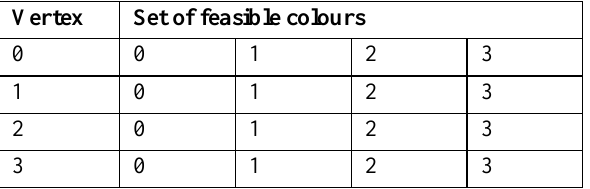
Table 2: Colour matrix created for the graph of figure